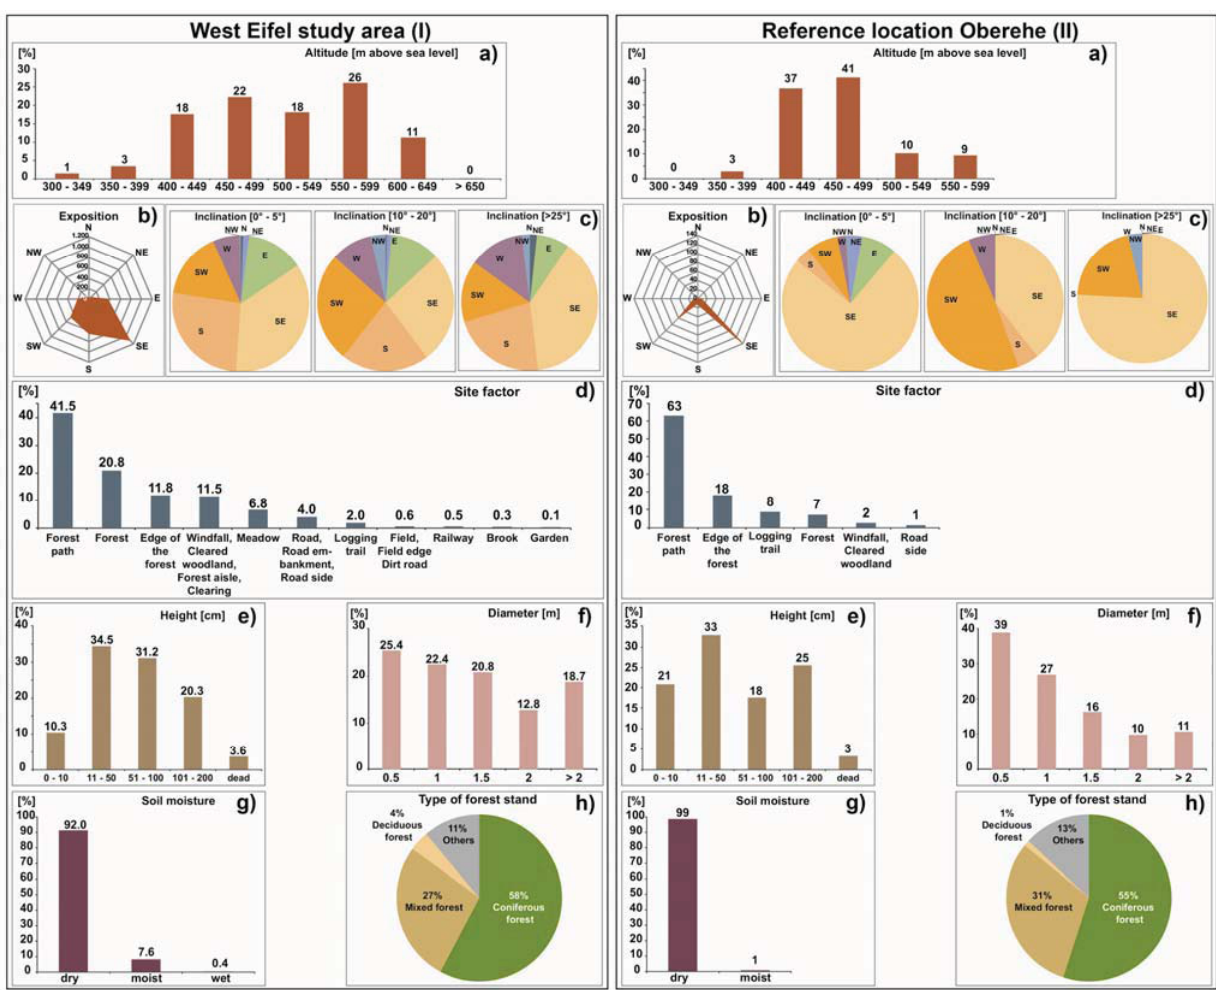
area ( I ) and reference location Oberehe ( II ). Given numbers are for altitude (m above sea level) ( a ), exposition [°] ( b ), inclination [°] ( c ), site factor ( d ), height [m] ( e ), diameter [m] ( f ), site moisture ( g ) and type of forest stand ( h